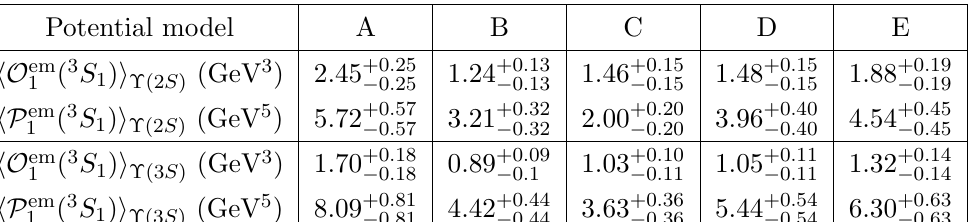
Table 11 . Results for the matrix elements h (cid:7)( nS ) jO em j (cid:7)( nS ) i at the scale (cid:22) (cid:3) = M Wavefunctions at the origin and binding energies have been computed within the potential models of section